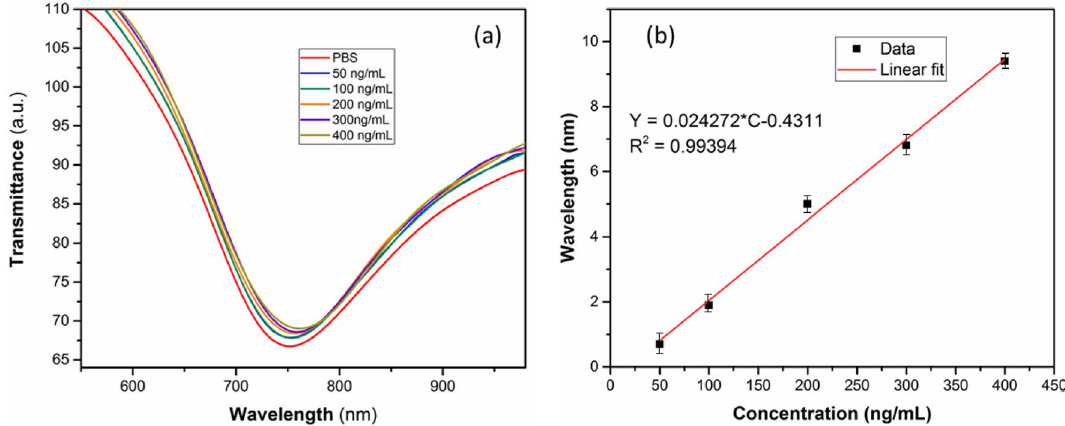
Figure 6. ( a ): SPR wavelength shifts of the Ab(Ft)/L-Cysteine/MoS 2 /OF-SPR biosensor with respect to different concentrations to Ferritin; ( b ): Corresponding linear calibration curve, all measurements are an average of 3